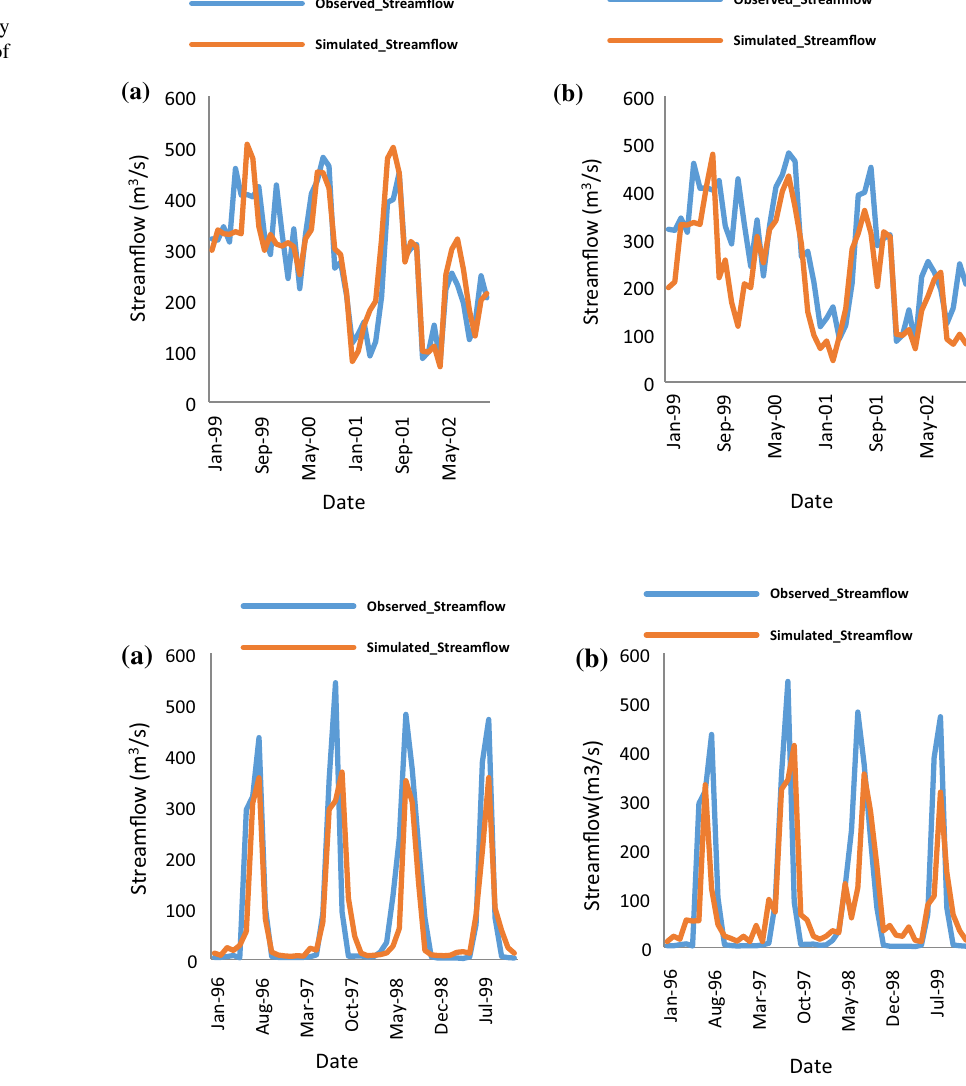
Fig. 12 Hydrograph of the observed and validated monthly flow for the validation period of Pong dam for a ERA-Interim and b IMD weather data